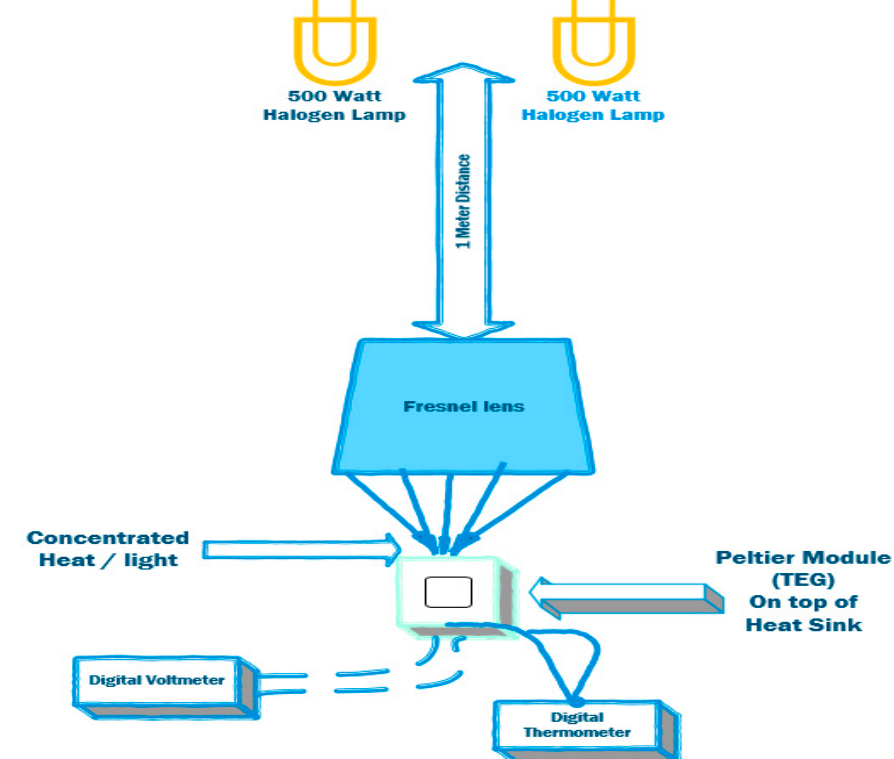
Figure 6. Schematic diagram of the concentrated quartz-halogen (2500 W lamps) radiative heat harvesting using Fresnel lens with Peltier module.